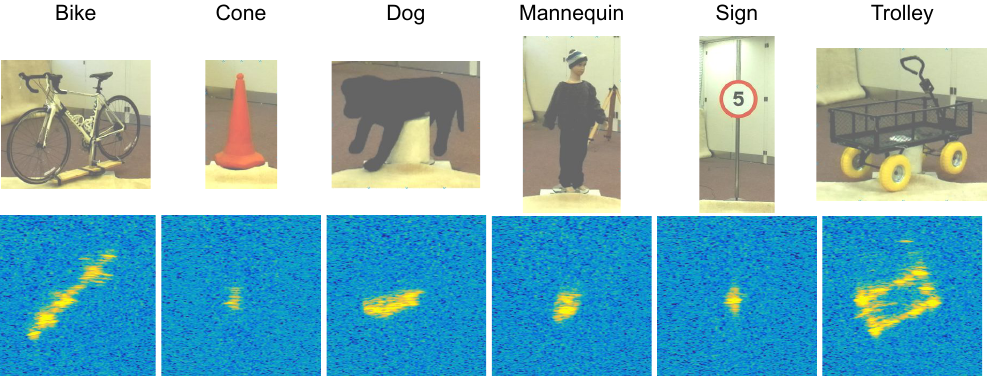
Figure 3. Samples from each object at 3.8 m from the dataset collected using the 300 GHz radar [8].